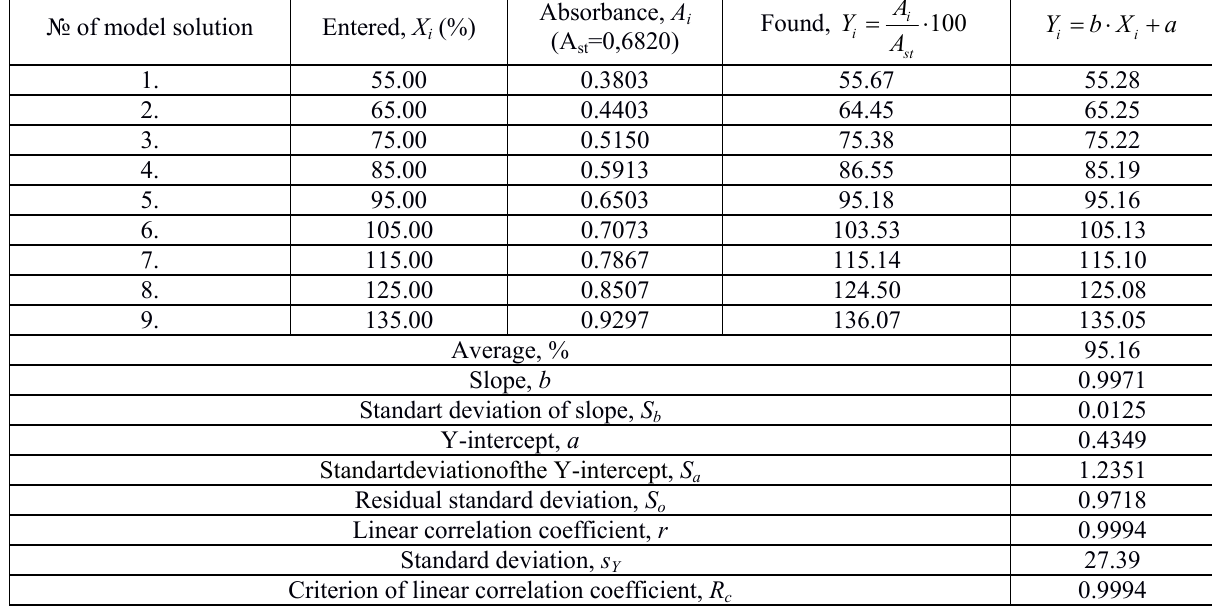
 – confidence interval; n – amount of Z